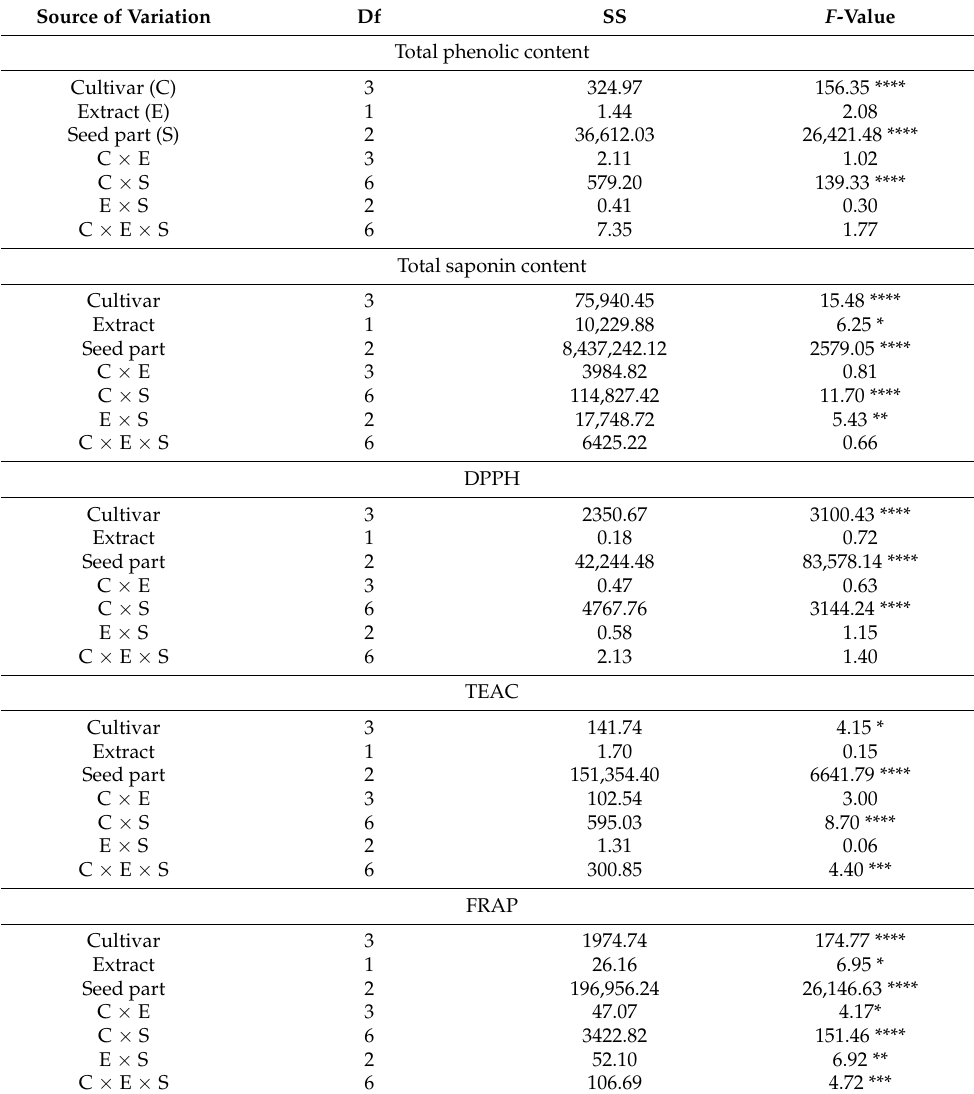
Table 4. Analysis of variance showing the effects of cultivar, extract type, seed parts and their interactions on metabolite contents and antioxidant activities in adzuki